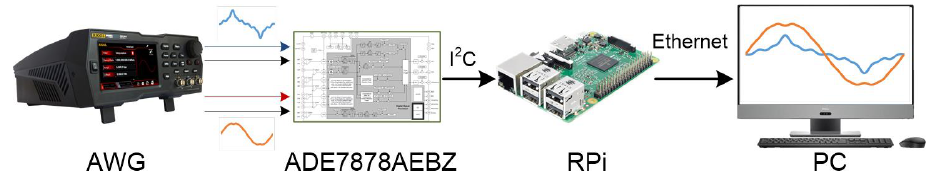
Figure 4. Experimental